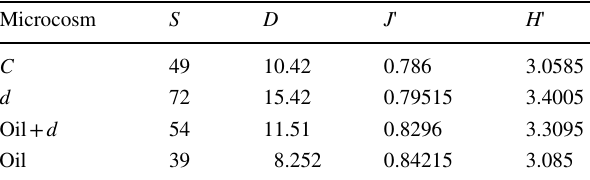
Table 7 Mean of univariate indices values for bacterial assemblages observed in microcosms, exposed to different treatments ( C : control, d : dispersant, oil: Oil, oil + dispersant: Oil + d ). S = number of spe- cies; Margalef’s D = species richness; H ' = Shannon–Wiener index; Pielou’s J ’ = evenness